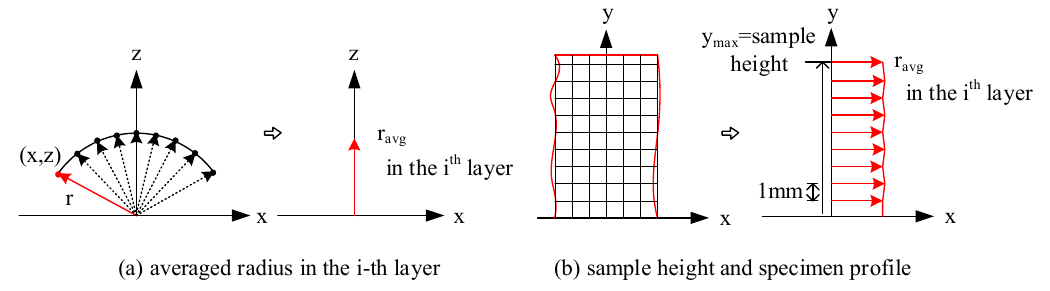
Figure 27. Schematic illustration of averaging radius at each specific height of the specimen.